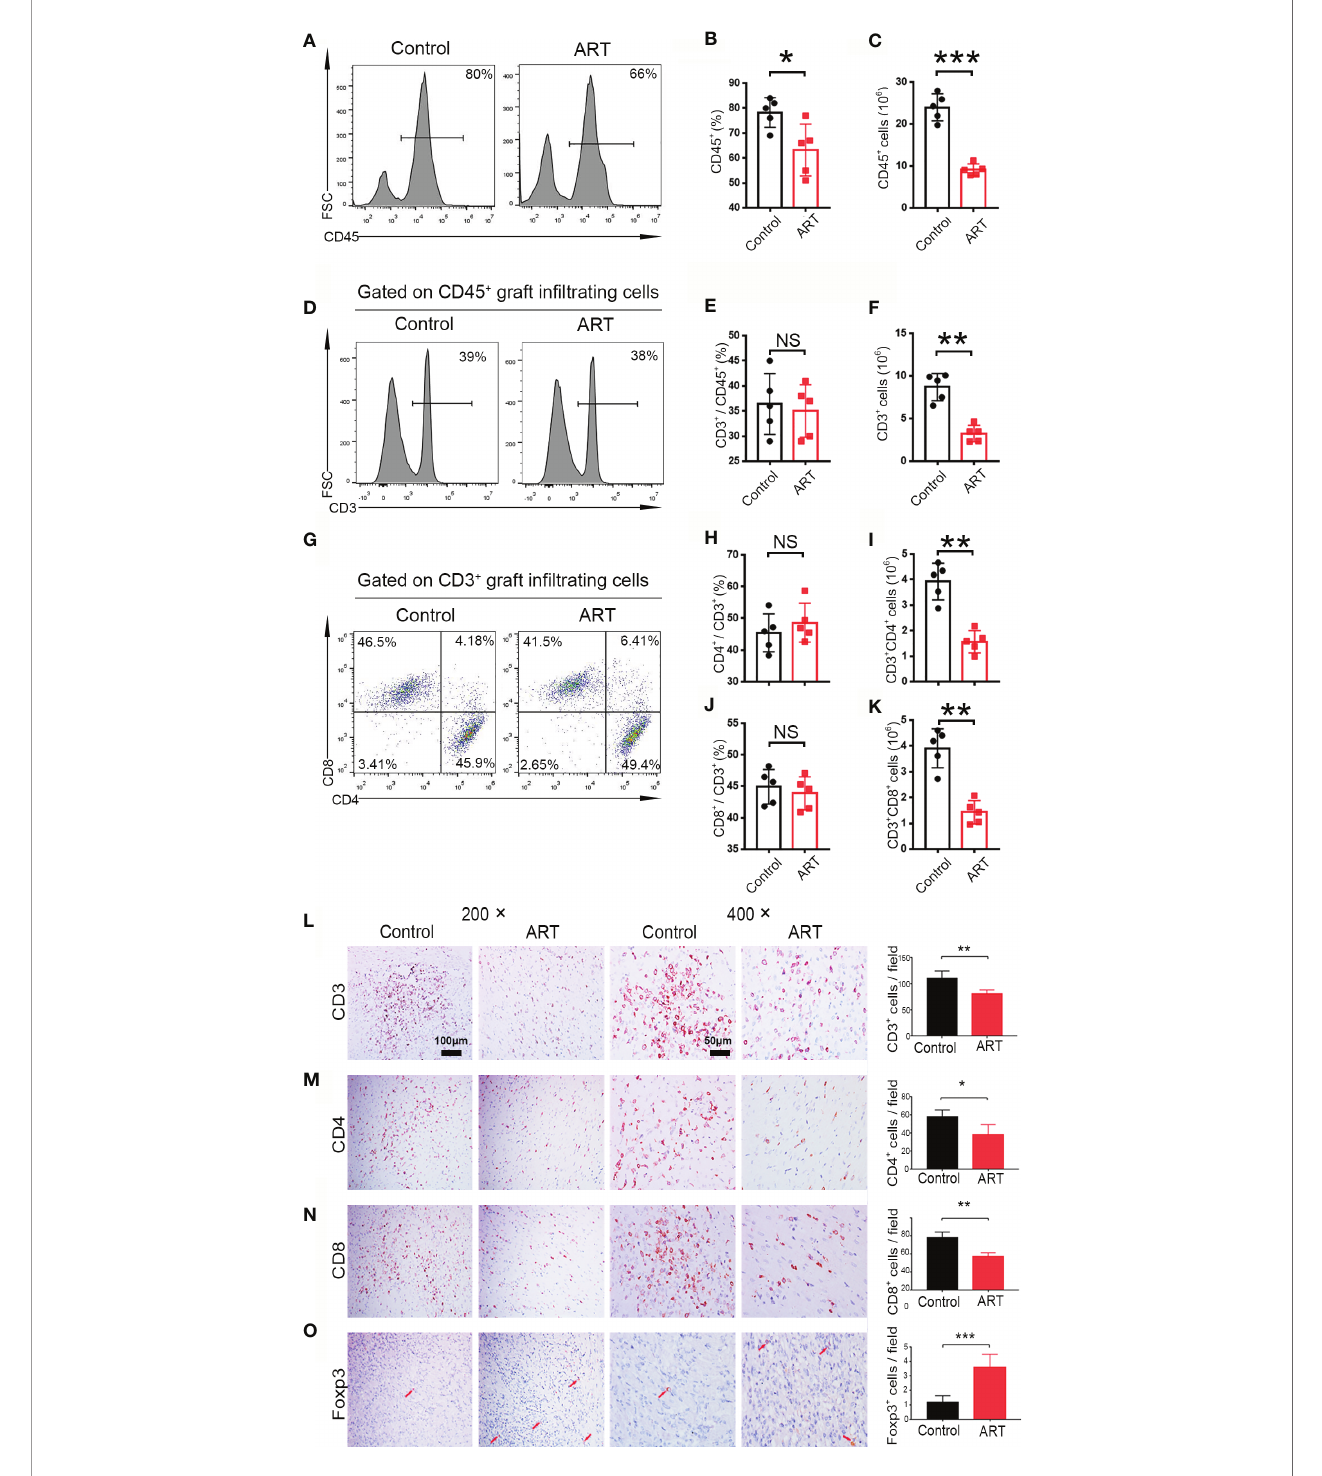
FIGURE 2 | Artemisinin (ART) reduces T cell in fi ltration in cardiac allografts. Lymphocytes (CD45 + ), T cells (CD3 + ), CD4 + T cells (CD3 + CD4 + ), and CD8 + T cells (CD3 + CD8 + ) in cardiac allografts were detected by fl ow cytometry. Representative histograms and quantitative analysis of frequencies and counts of lymphocyte cells (A – C) , T cells (D – F) , CD4 + T cells and CD8 + T cells in allografts (G – K) (n = 5/group). (L – O) Representative immunohistochemistry staining images and results of quantitative analysis of cell numbers/view based on CD3, CD4, CD8, and Foxp3 in the Control and ART groups (n = 5/group). Magni fi cation: 200× and 400×. * P < 0.05; ** P < 0.01; *** P < 0.001. NS, no signi fi